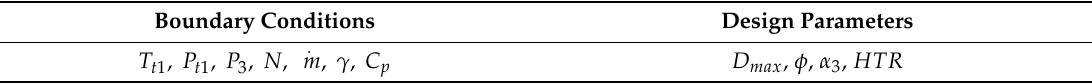
Table 1. Boundary conditions and design parameters required for meanline